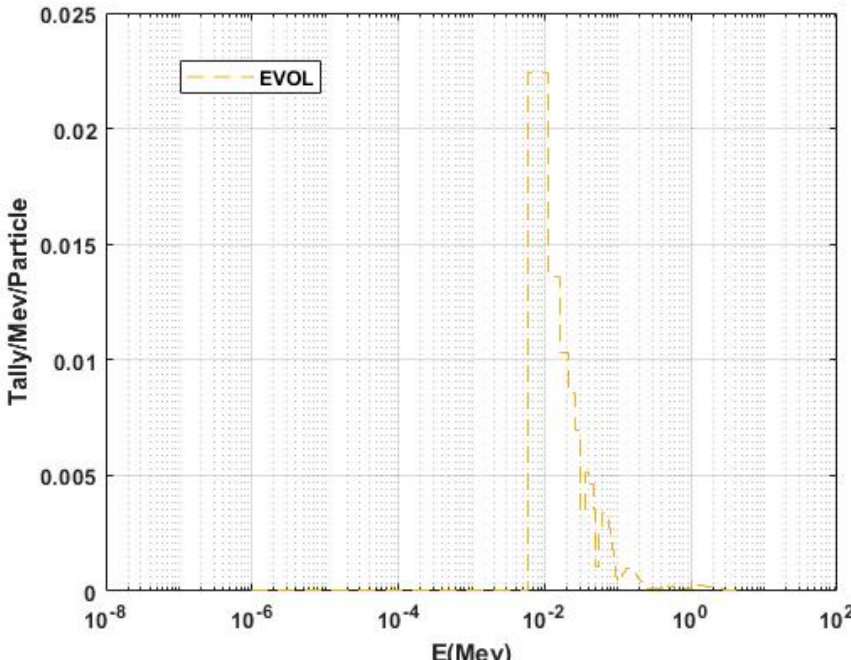
Figure 8. Neutron fluxenergy spectrum for EVOL salt fuel system.